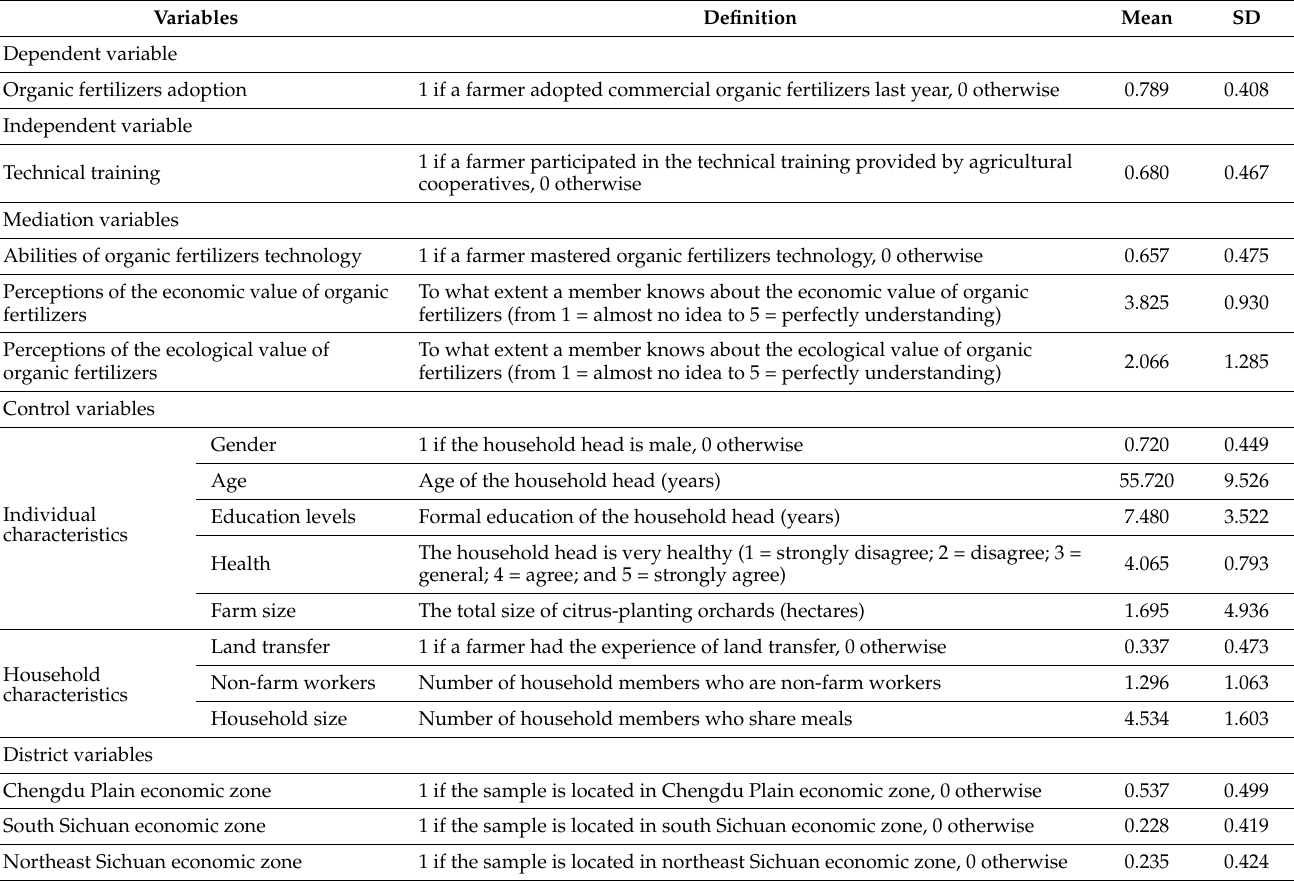
Table 1. The definitions and summary statistics of the variables used in the